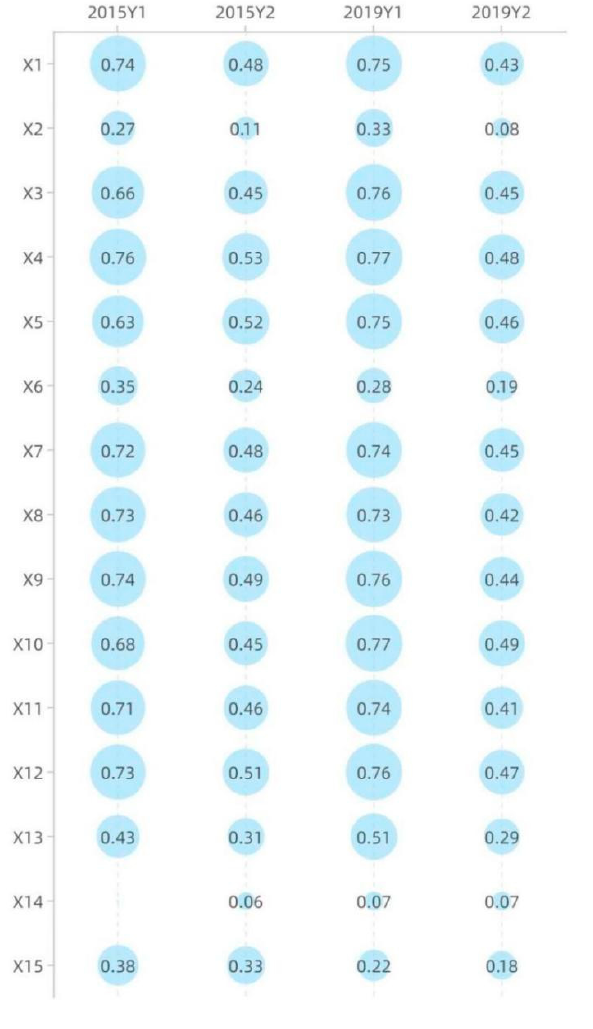
Figure 6. Change of factor influence from 2015 to 2019.